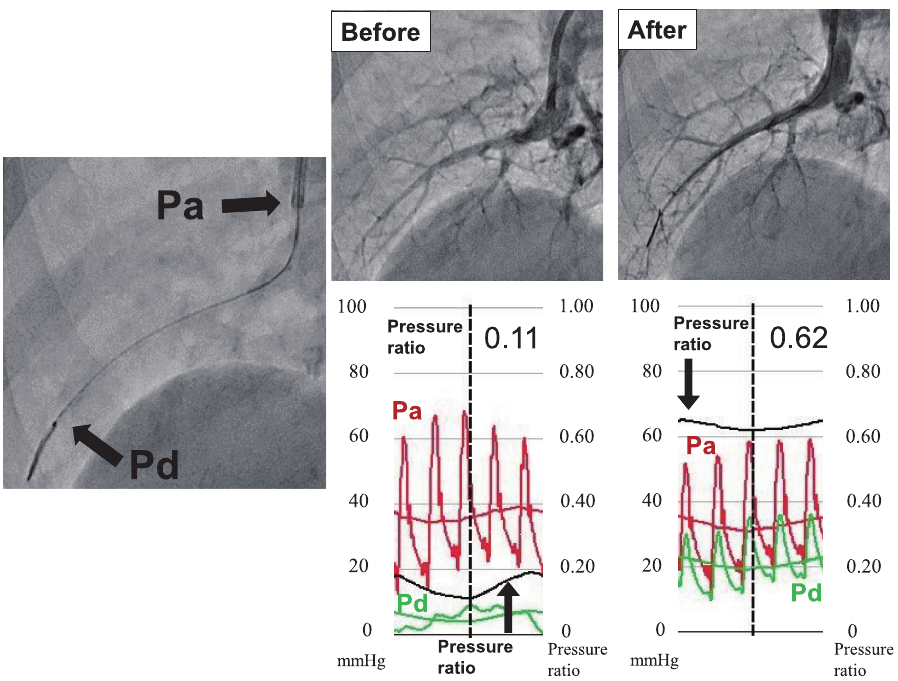
Fig 2. Assessment of pressure ratio by pressure catheter. (A) Measuring of blood pressure. Pa was measured by guiding catheter and Pd was measured by pressure microcatheter. (B) Angiography and pressure ratio before and after balloon dilatation. Pressure ratio was defined as Pd /